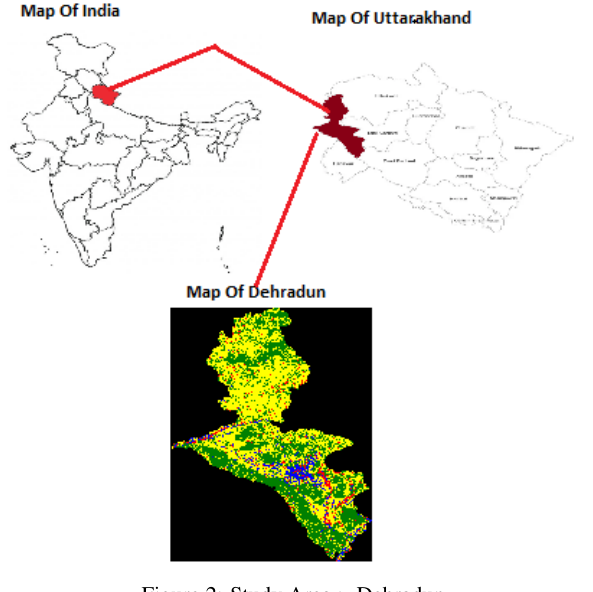
Figure 2: Study Area :- Dehradun